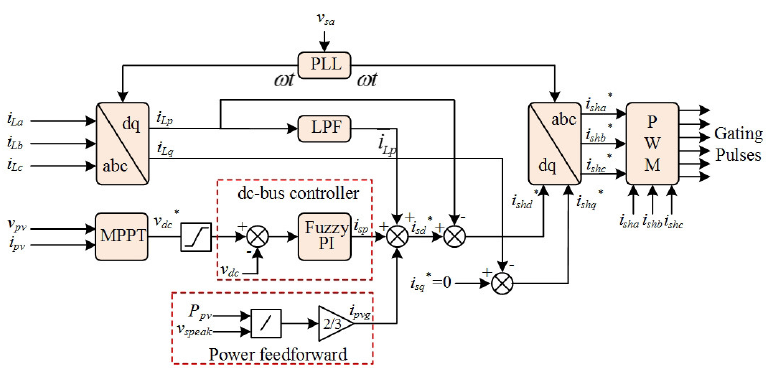
Figure 3. Control loop of the shunt